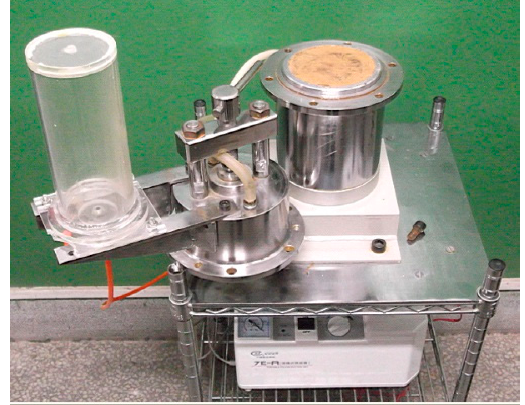
Figure 1. Structure of the device developed for testing EEF.